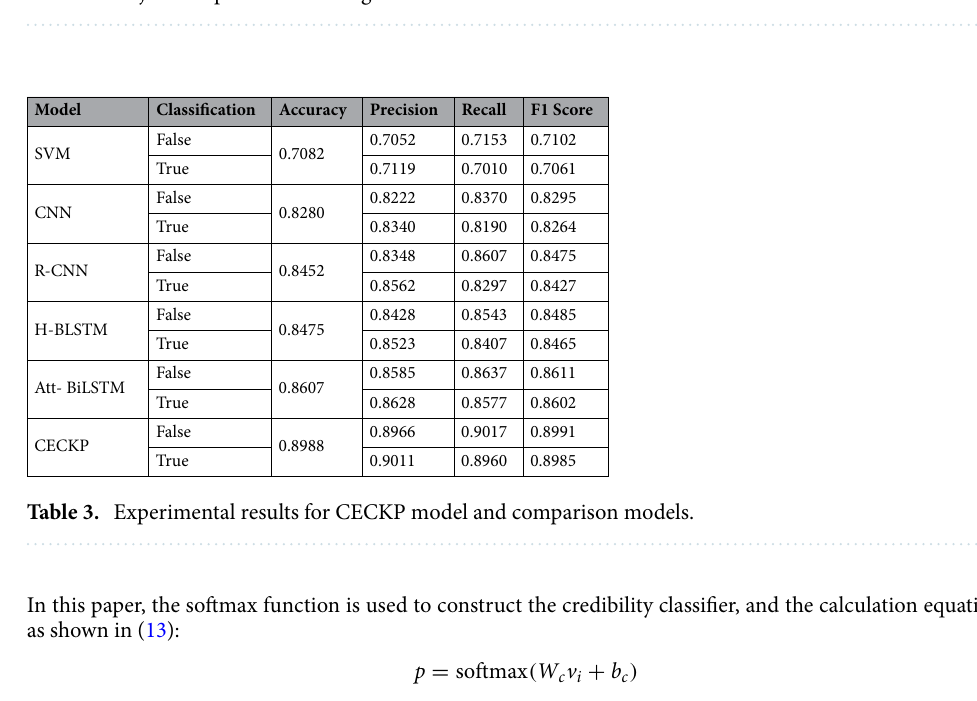
Table 2. Adjustable parameter settings.